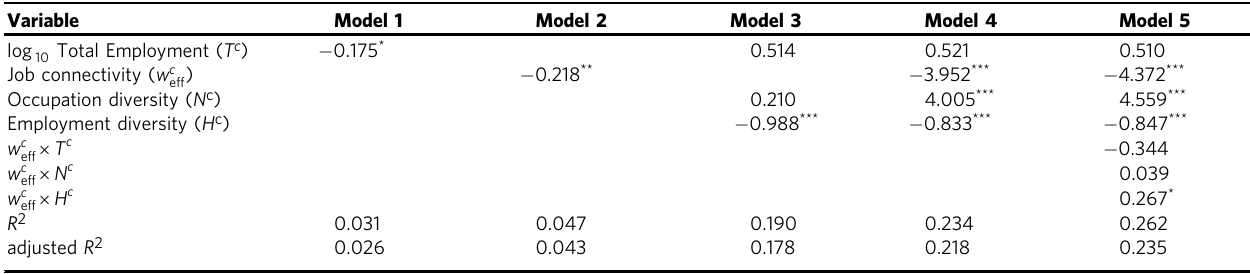
Table 1 Linear regression models predicting the peak unemployment rate in US cities during the Great Recession. Using 2007 employment data from the year before the recession, labor diversity measured through urban employment distributions ( H c ), occupation diversity ( N c ), and job connectivity ( w eff ) predict labor responses to Great Recession. Variables were centered and standardized prior to